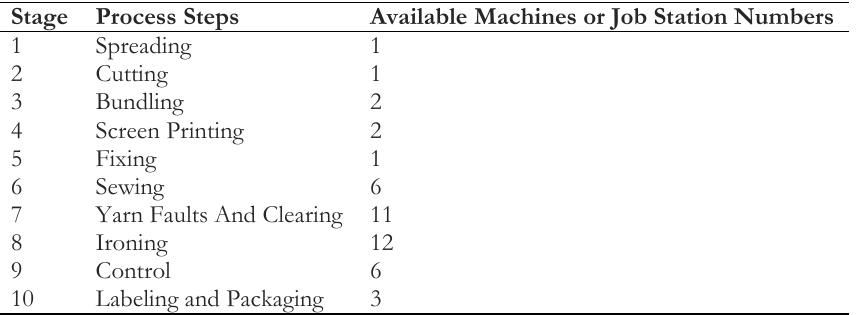
Table 4. Apparel manufacturing process steps and machines or job station